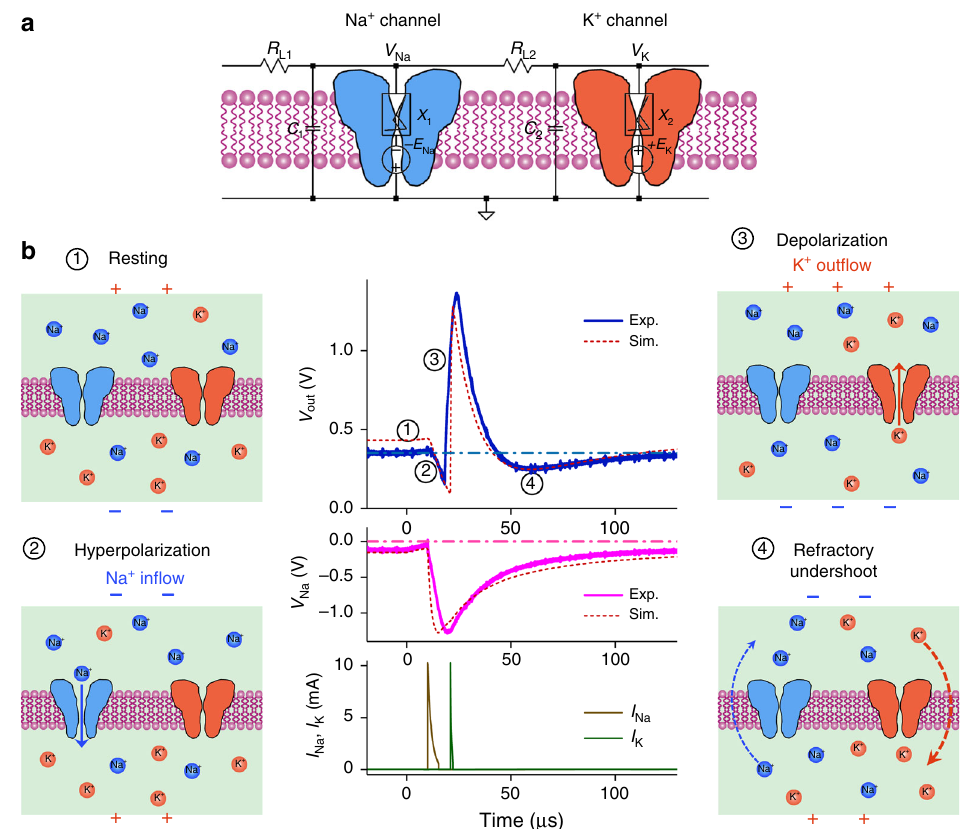
Fig. 2 Action potential generation in a VO 2 active memristor neuron. a Circuit diagram of a VO 2 memristor neuron, consisting of two resistively coupled Pearson-Anson relaxation oscillators ( R L1 , C 1 , X 1 and R L2 , C 2 , X 2 , respectively). The negatively-biased memristor X 1 acts as the voltage-gated Na + channel, and the positively-biased memristor X 2 acts as the voltage-gated K + channel. Capacitors C 1 and C 2 are the corresponding membrane capacitances. b